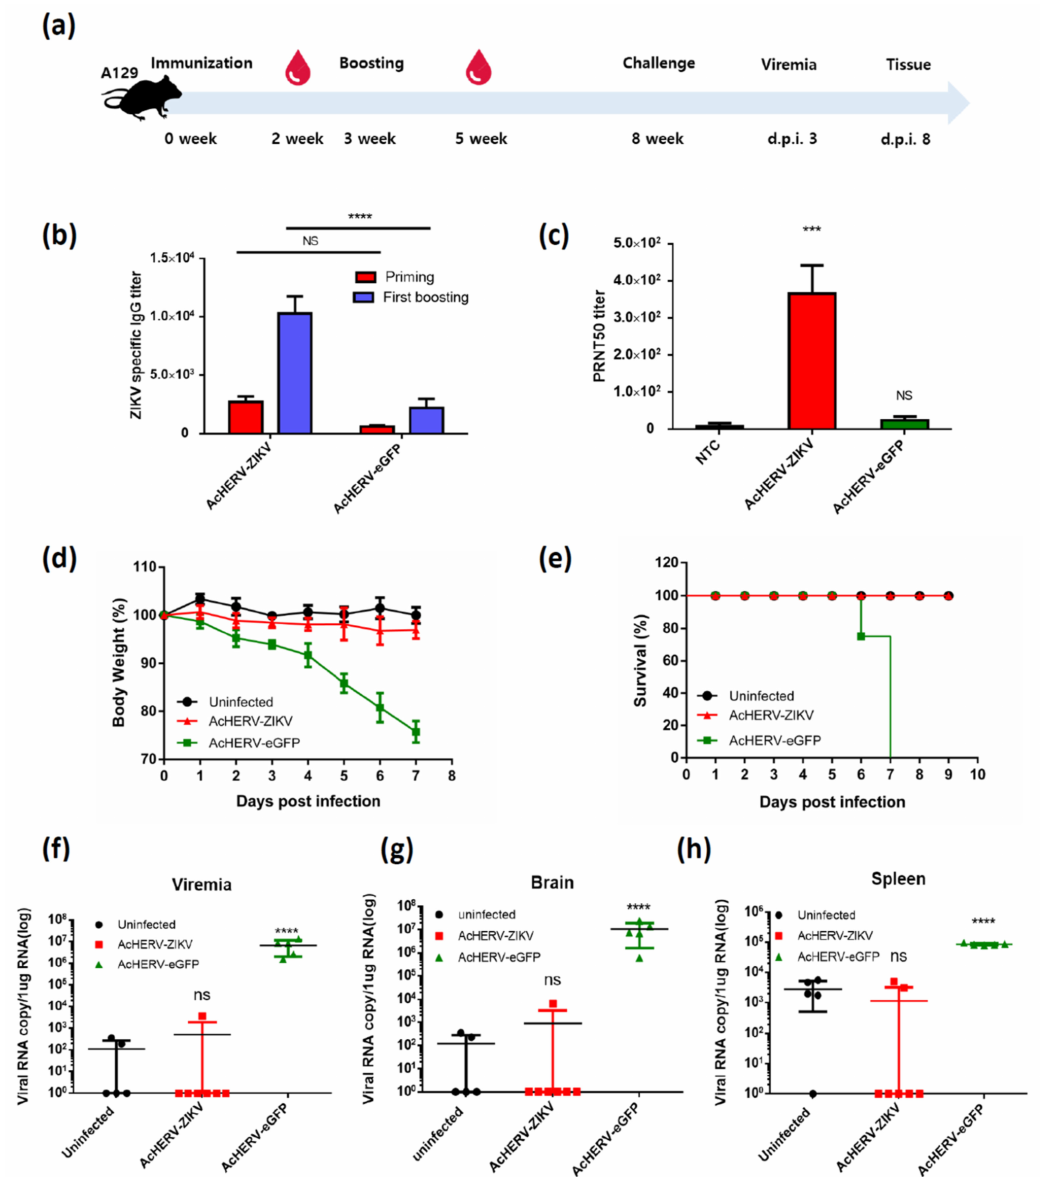
Figure 3. Assessment of vaccine efficacy in ZIKV-challenged A129 mice. ( a ) Experimental design used to assess the effect of vaccination in ZIKV-challenged A129 mice. ( b ) Humoral immune responses were evaluated using indirect ELISA. ( c ) Levels of ZIKV-specific neutralizing antibodies were analyzed using immunized mouse sera. **** p < 0.0001, *** p < 0.001, ns, not significant, compared with the placebo group. ( d ) Survival rates of mice after the ZIKV challenge. ( e ) Loss of body weight was analyzed after the ZIKV challenge. ( f ) After 3 days of ZIKV challenge, RNA levels of ZIKV in mouse sera were analyzed by qRT-PCR analysis. After 8 days of ZIKV challenge, ZIKV RNA levels were measured by qRT-PCR analysis in brain ( g ) and spleen ( h ). **** p < 0.0001, ns, not significant, compared with the uninfected